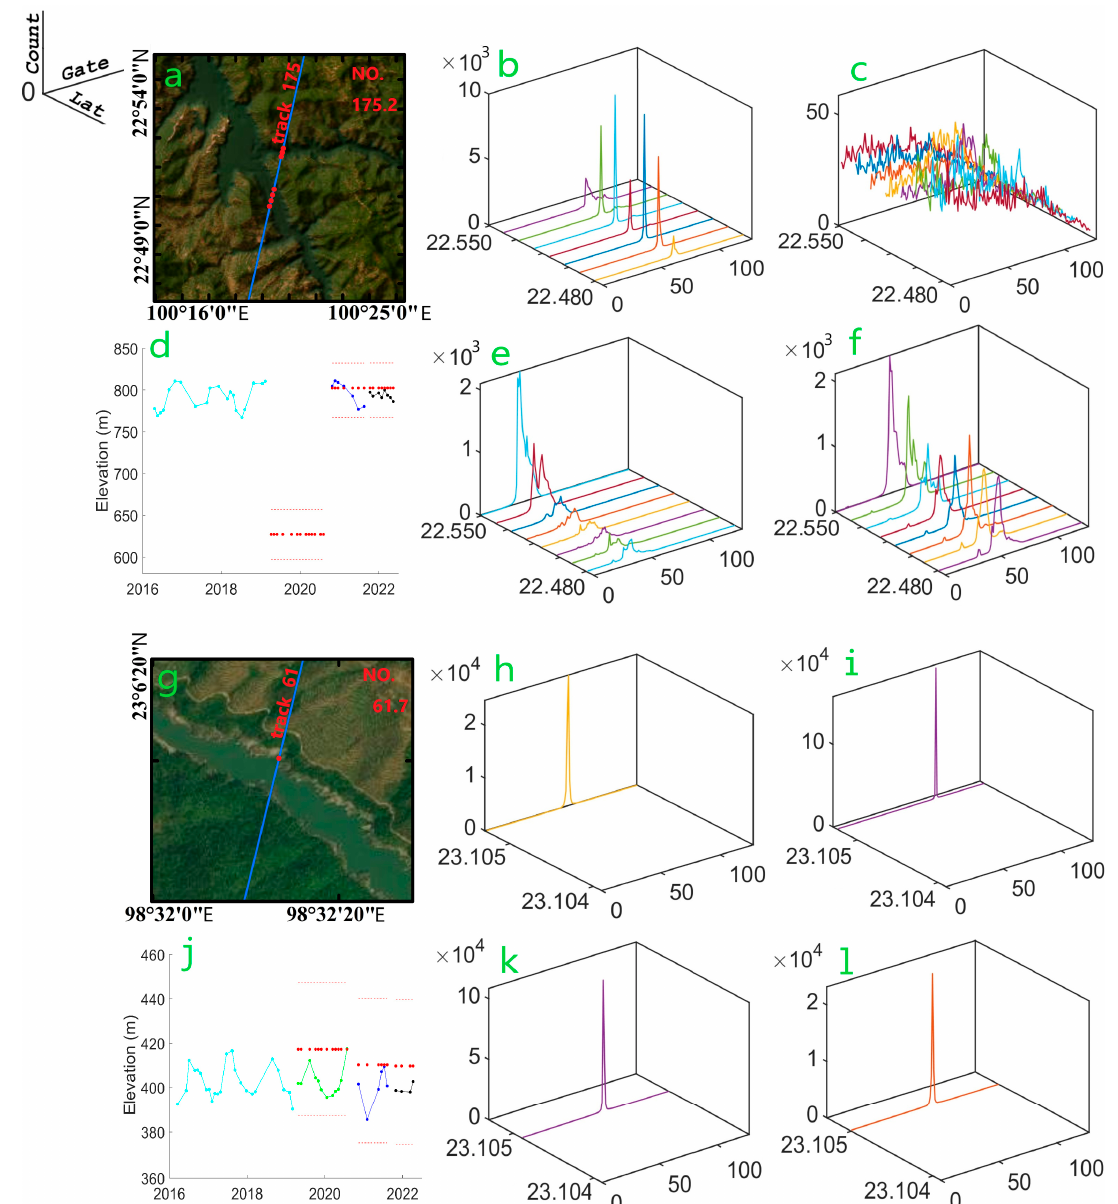
Figure 6. Two typical cases of virtual stations (VSs) in ( a – f ) low elevation and wide river (LW) and ( g – l ) low elevation and narrow river (LN). The satellite image shows the locations of the VSs, with the orbit of Sentinel ‐ 3A (S3A) indicated by the blue line. The orbit numbers are shown in red next to the orbit, and the red dots on the orbit indicate the location of the satellite emitting detection waves at the corresponding VSs. The VSs number is displayed in red font in the upper right corner of the image. The red dots in the scatter chart ( d , j ) represent the elevation of OLTC while the pink dots represent the size of the range window. The four waveforms refer to the closed ‐ loop ( b , h ) and OLTC V5.0 ( c , i ), OLTC V6.0 ( e , k ), and OLTC V6.1 ( f , l ). ( d , j ) Show the time series of the WSE for the specific VS, where azure, green, blue, and black refer to closed ‐ loop, OLTC V5.0, OLTC V6.0, and OLTC V6.1.